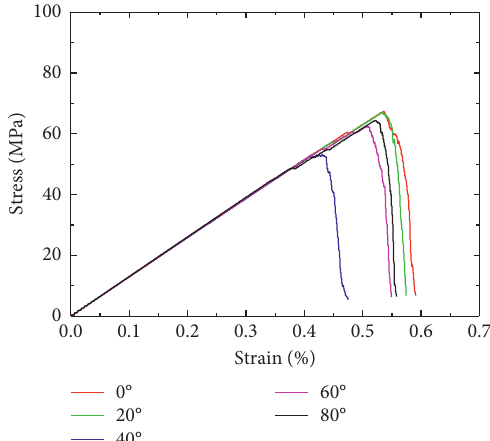
Figure 10: Stress-strain curves of rock samples with different boreholes spacing.